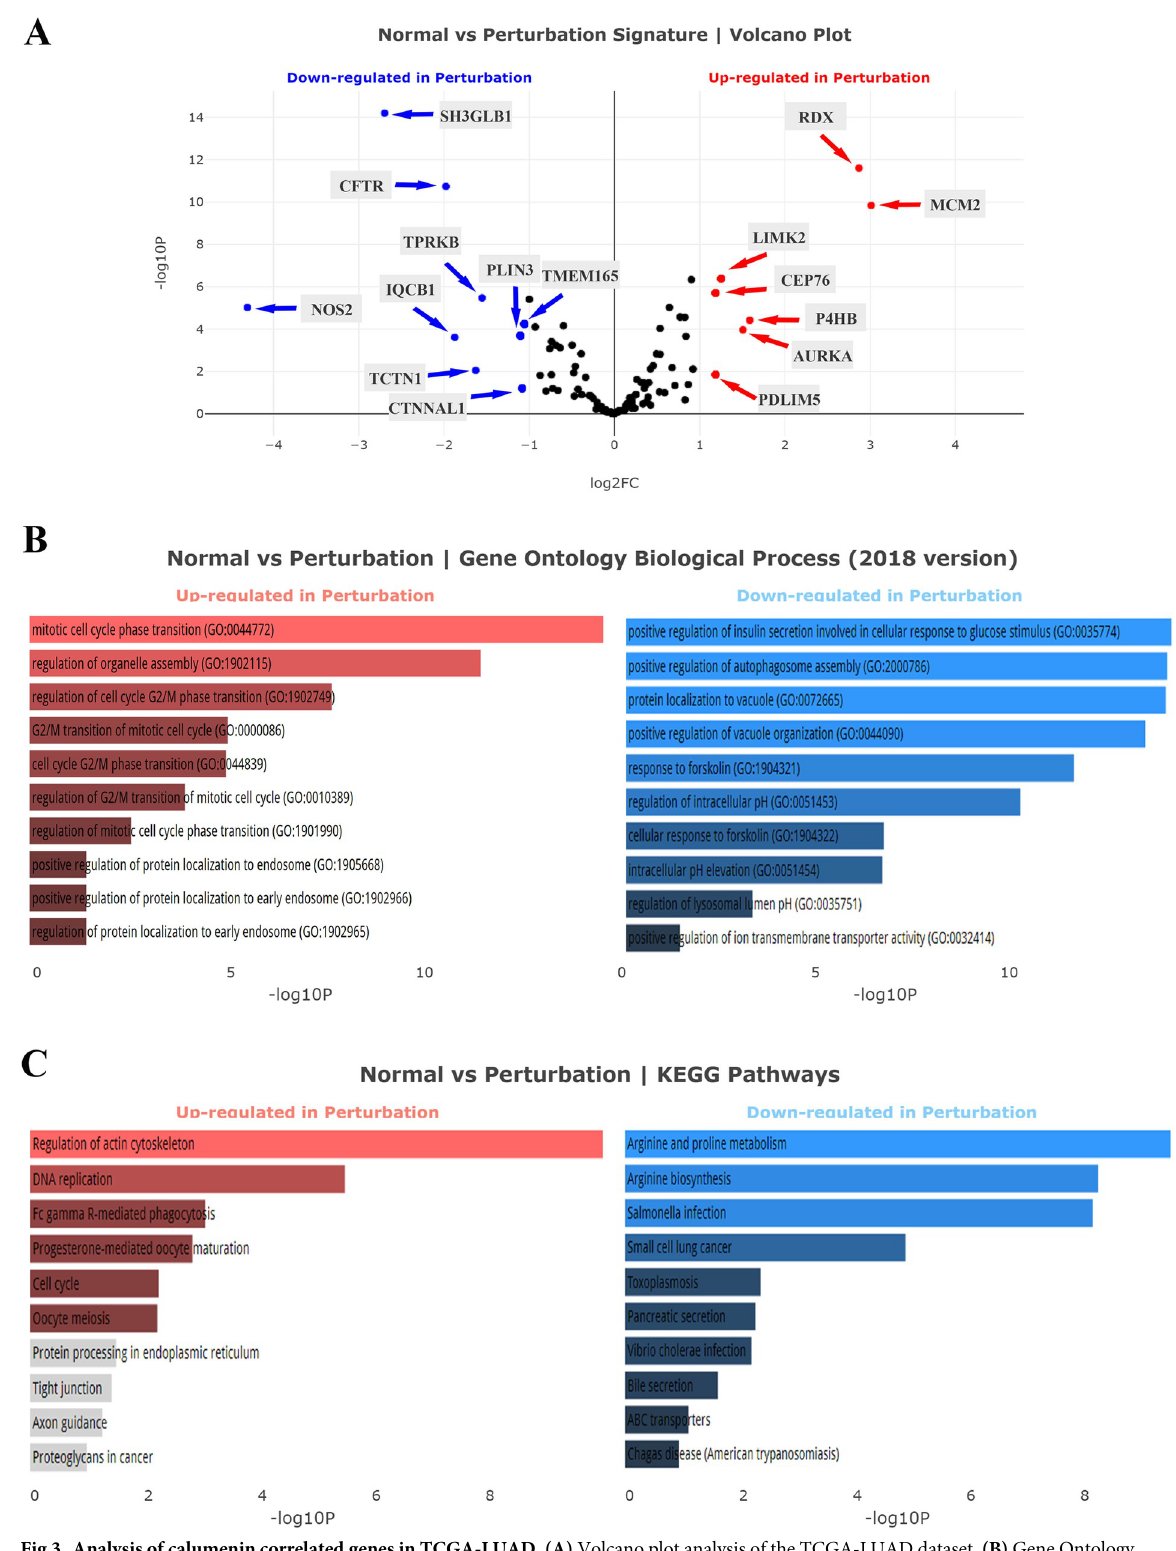
Fig 3. Analysis of calumenin correlated genes in TCGA-LUAD. (A) Volcano plot analysis of the TCGA-LUAD dataset. (B) Gene Ontology (GO) biological process analysis. (C) KEGG pathways analysis. The statistical significance of each gene was calculated using the Cuffdiff package